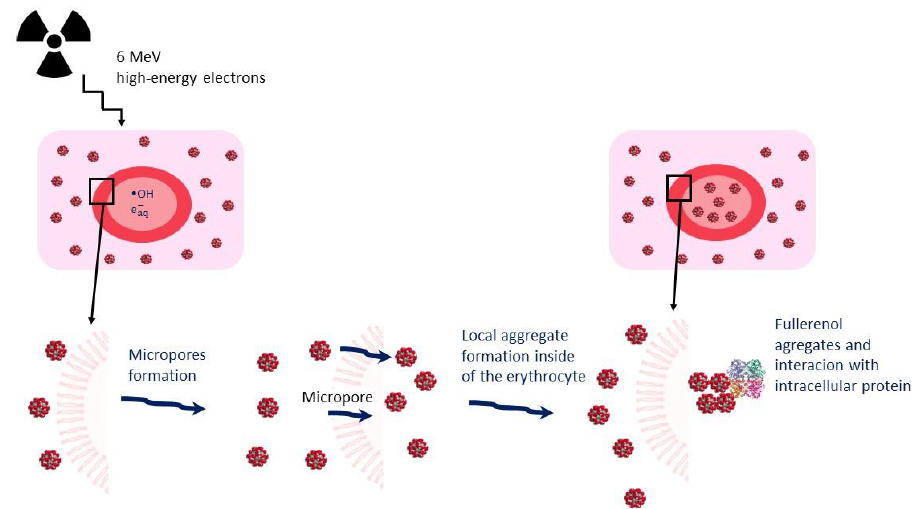
Figure 4. Proposed mechanism of micropore formation by IR and local aggregate formation of C 60 (OH) 36 molecules and interaction with internal proteins inside erythrocyte.